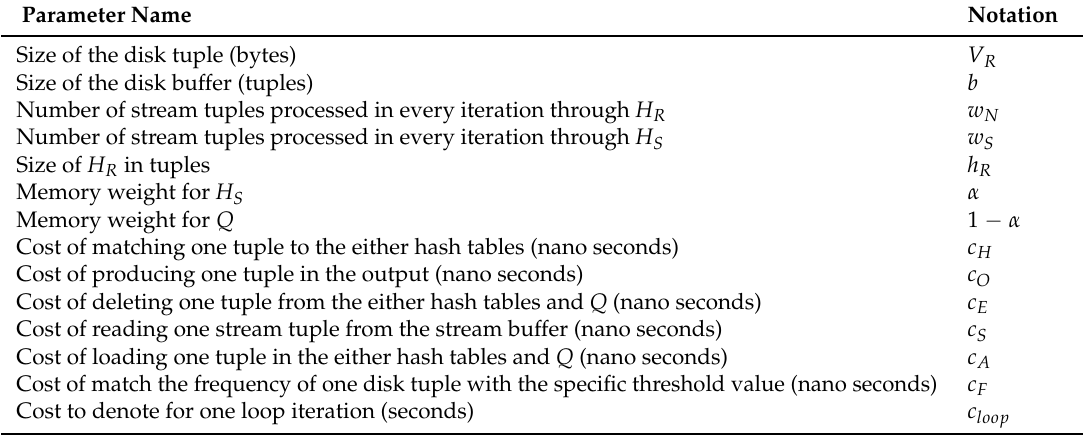
Table 1. Symbols used in memory and processing cost calculation of